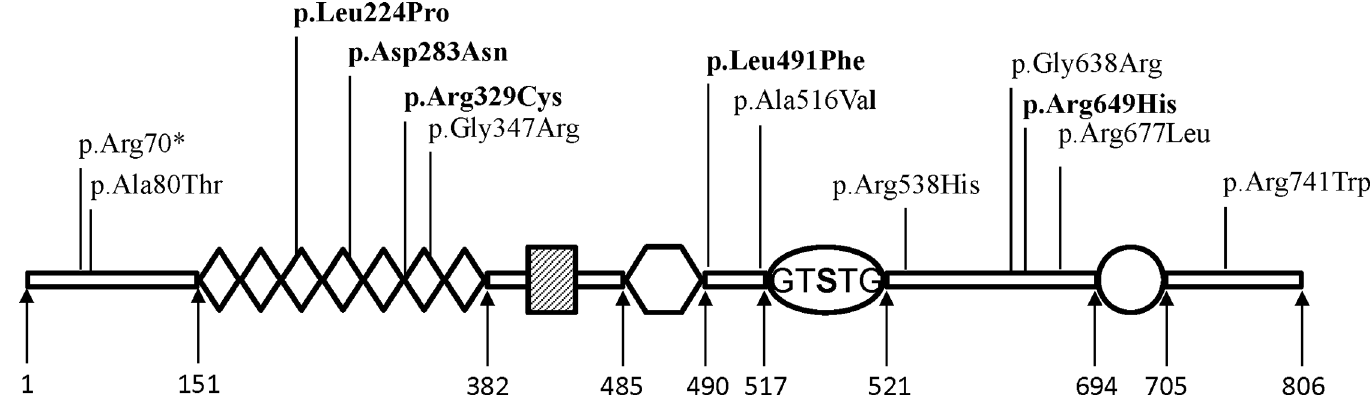
Fig 4. Schematic representation of PLA2G6 and location of mutations identified in present study. PLA2G6 consists of seven ankyrin repeats (diamond), a proline-rich motif (gridded box), a nucleotide binding motif (hexagon), a lipase motif (oval) and a binding site for calmodulin (circle). Numbers shown below are the amino acid positions. Five novel mutations are shown in